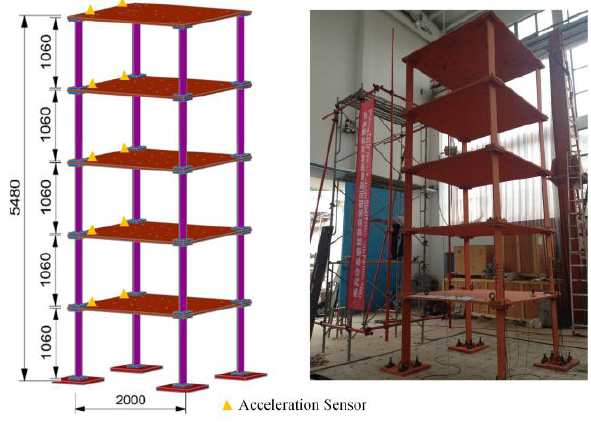
Figure 9. Schematic diagram and the test model of the 5-DOF structure system.